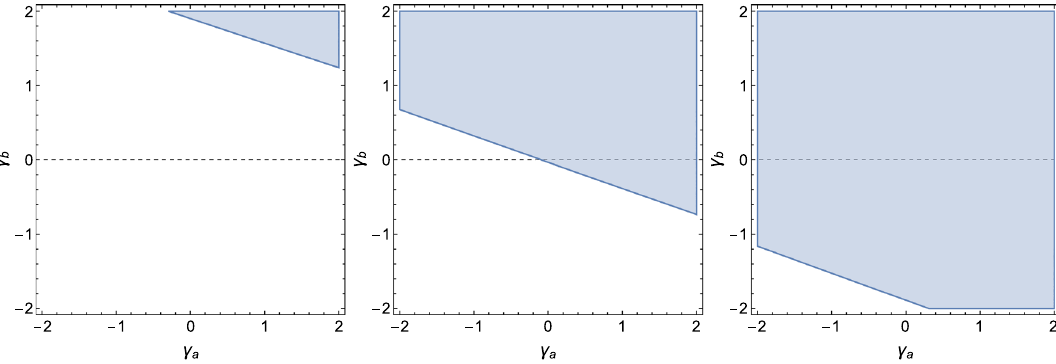
Fig. 2 Possible parameter space between γ a − γ b for fixed a ∗ = 1, L = 1, k = 1, λ = 0 . 1: left γ c = − 1, Middle γ c = 0, right γ c = 1